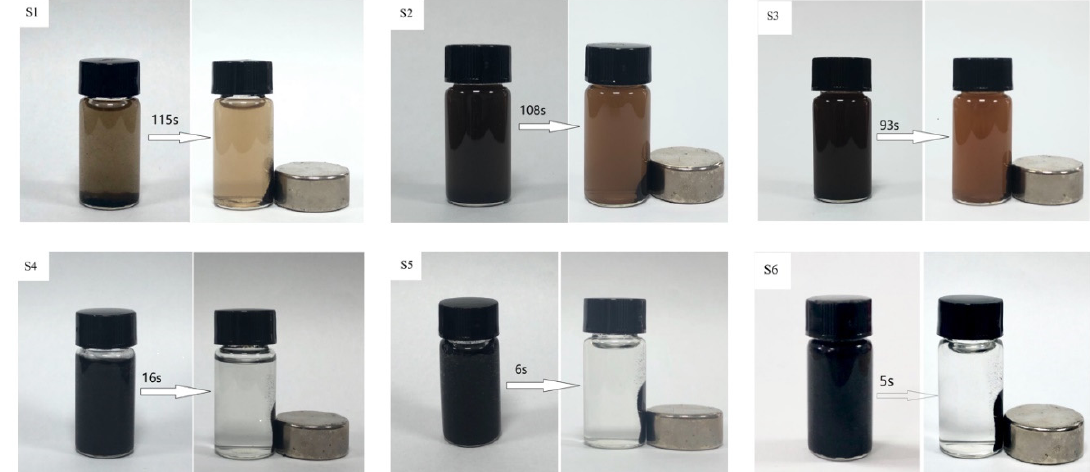
Figure 4. Dispersion degree of the samples (S1–S6) in ethanol solution and the magnetic response time of the samples after applied magnetic field were studied.